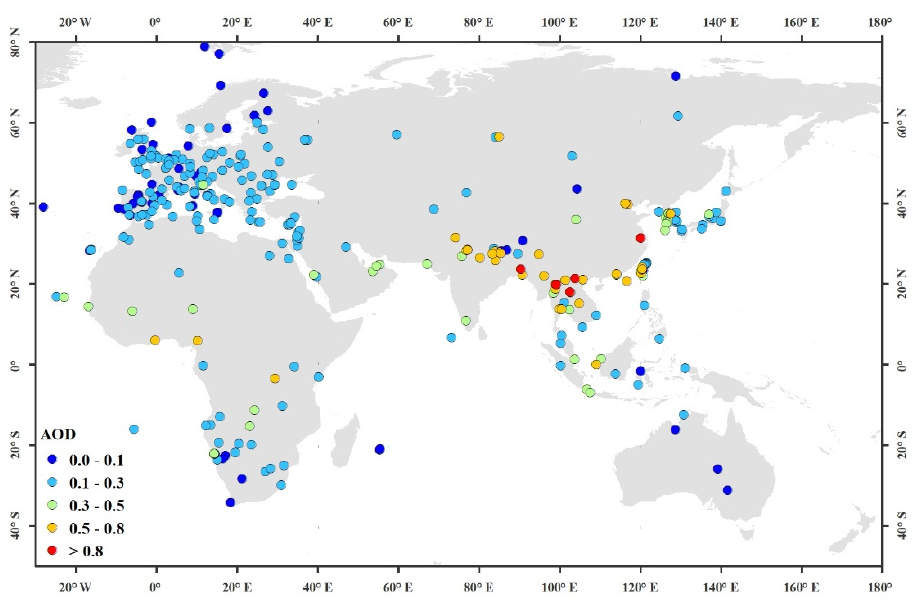
Figure 2. The average AOD of the collocated samples for each station.